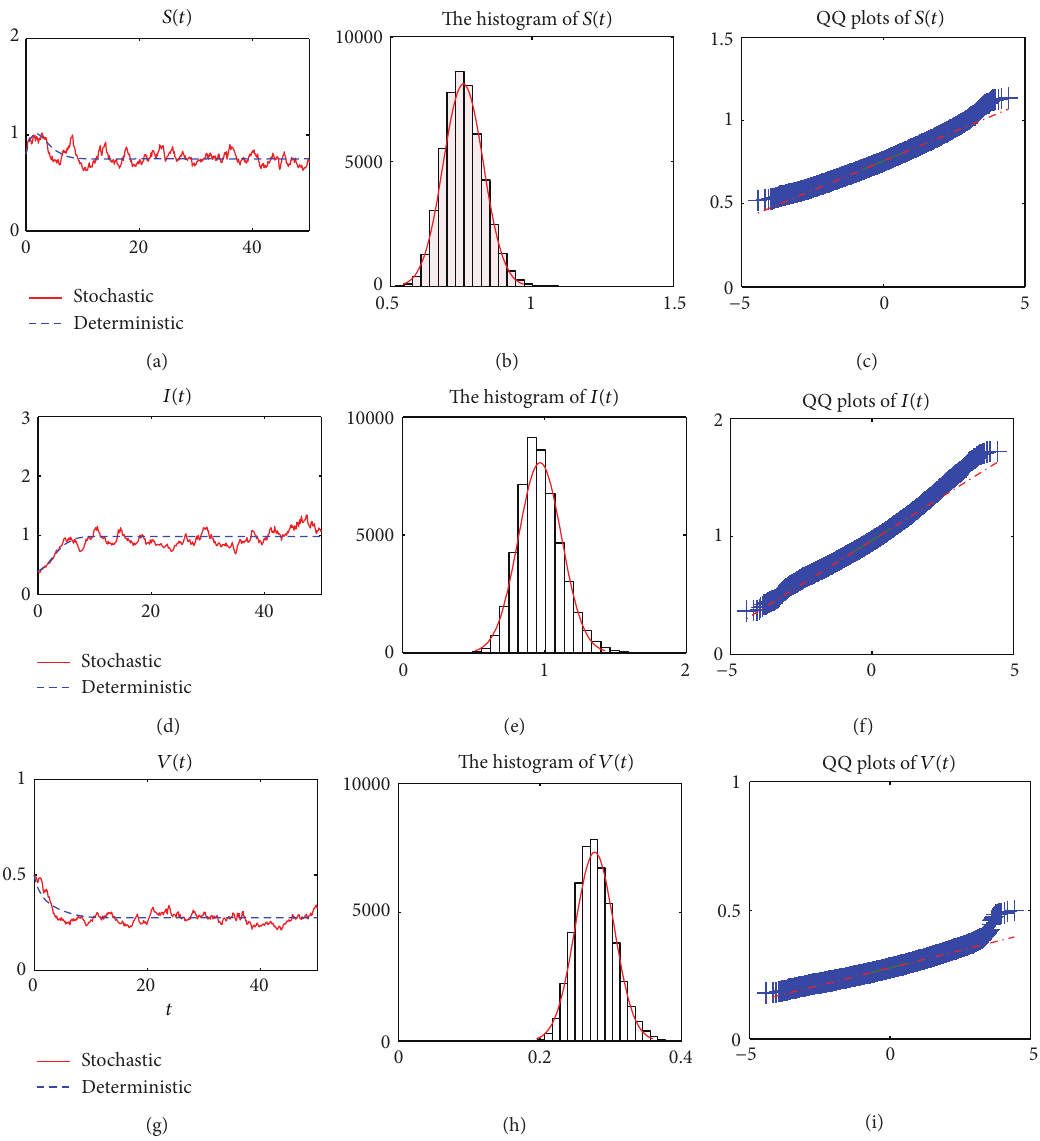
Figure 2: The solution of the stochastic system (6), its histogram, and normal quantile-quantile plots for parameter values 𝐴 = 0.9 , 𝑞 = 0.1 , 𝛽 = 0.8 , 𝜇 = 0.4 , 𝑝 = 0.1 , 𝛾 = 0.1 , 𝜀 = 0.2 , 𝛼 = 0.1 , 𝜎